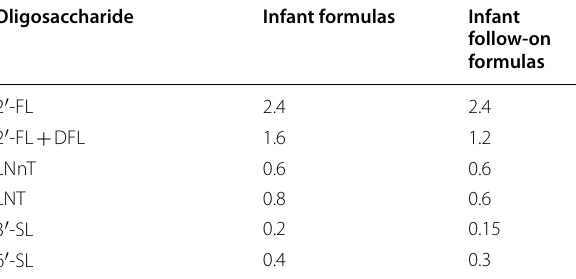
Table 1 The European Food Safety Authority (EFSA) maximum permitted levels of structurally identical synthetic human milk oligosaccharides or oligosaccharide combinations in infant formulas (in g/L) Oligosaccharide Infant formulas Infant